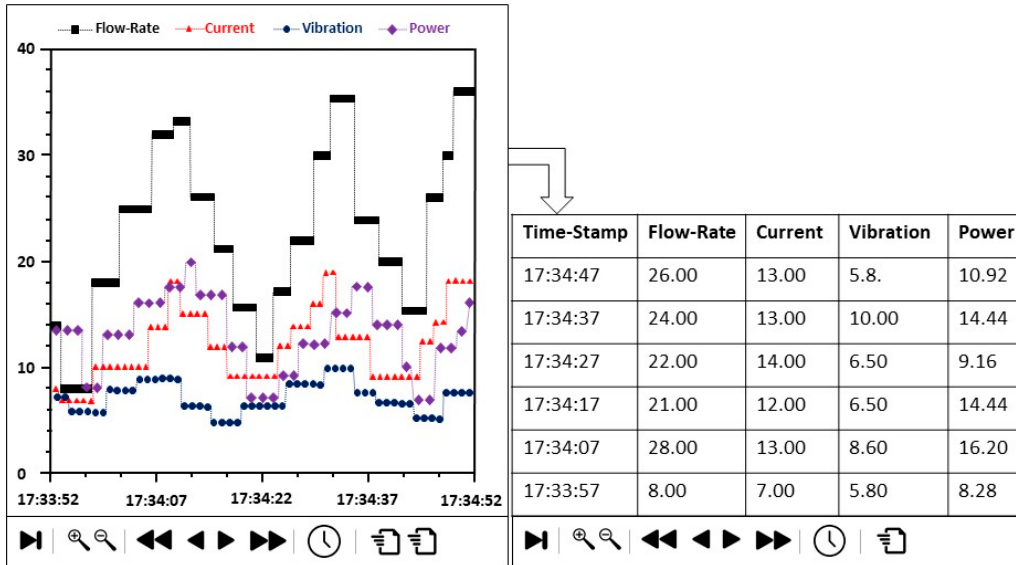
Figure 6. Collecting real-time data from various sensors of smart pump. J. Sens. Actuator Netw. 2019 , 8 , 25